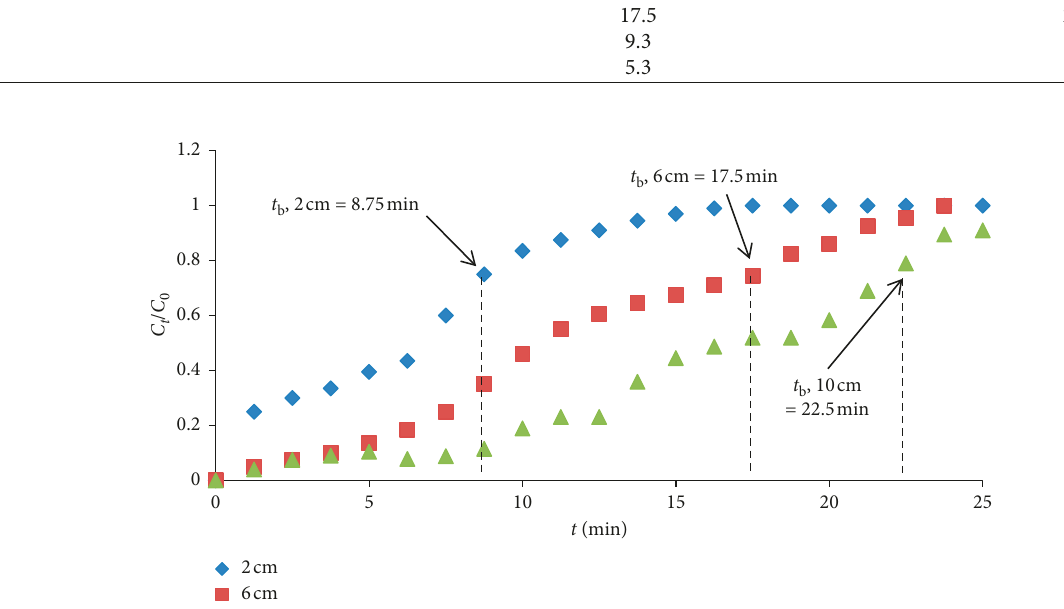
Figure 7: Effect of inlet fluoride concentration on breakthrough profile of QPKS (pH � 3, treated volume � 100ml, flow rate � 4ml/min, and bed height � 6 cm). Table 4: Breakthrough time and exhausted time at different inlet fluoride concentrations. Initial fluoride concentration (mg/L)